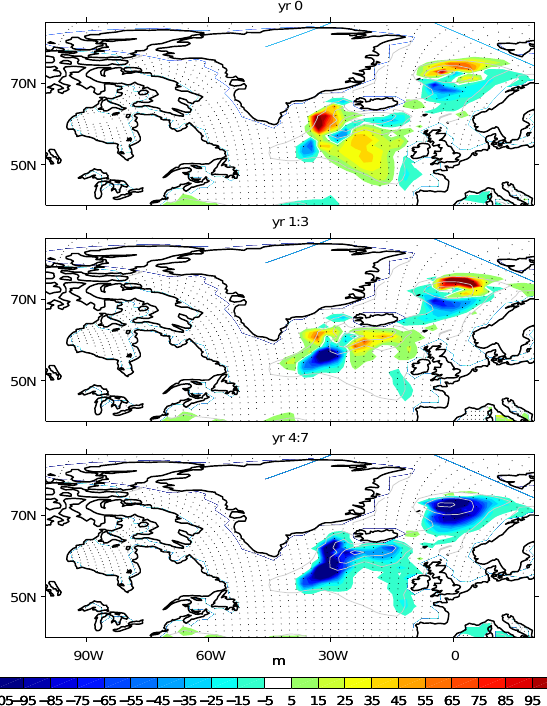
Fig. 13. composite of anomalous March sea ice cover during the Fig. 12. composites of anomalous March mixed layer depth during year following the eruption (left), 5 years later (middle), and 10 the year of the eruption (left), averaged over the following 3 years years later (right) for the period after 1400 A.D. Grey lines show (middle), and averaged 4 to 7 years later (right) for the period after contours of the average sea ice cover in March of 0, 0.5 and 1400 A.D. Grey lines show the annual mean mixed layer depth field in the model, with a contour interval of 500m .